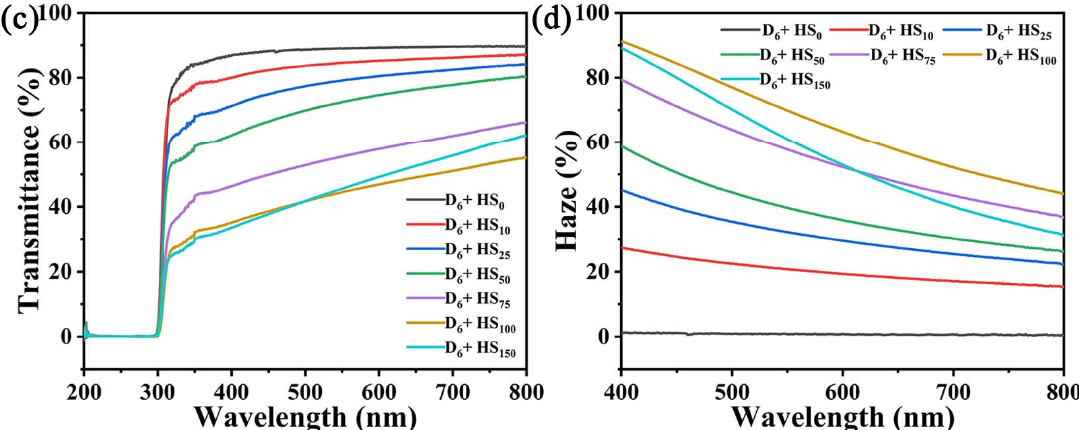
Figure 6. ( a ) Transmittance and ( b ) haze of HS n D 6 films. ( c ) Transmittance and ( d ) haze of D 6 + HS n films.